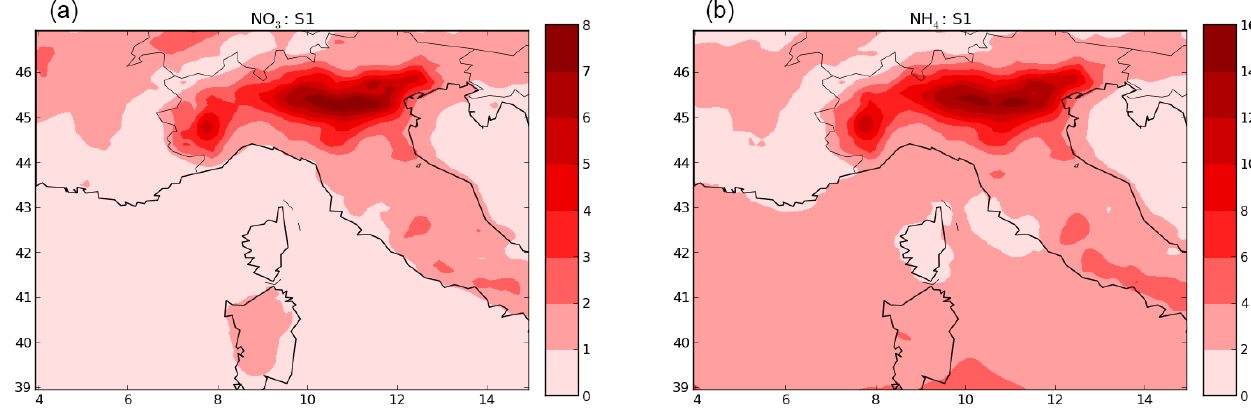
Figure D5. Maps of the concentrations of NO 3 (a) and NH 4 (b) in PM 10 during the summer